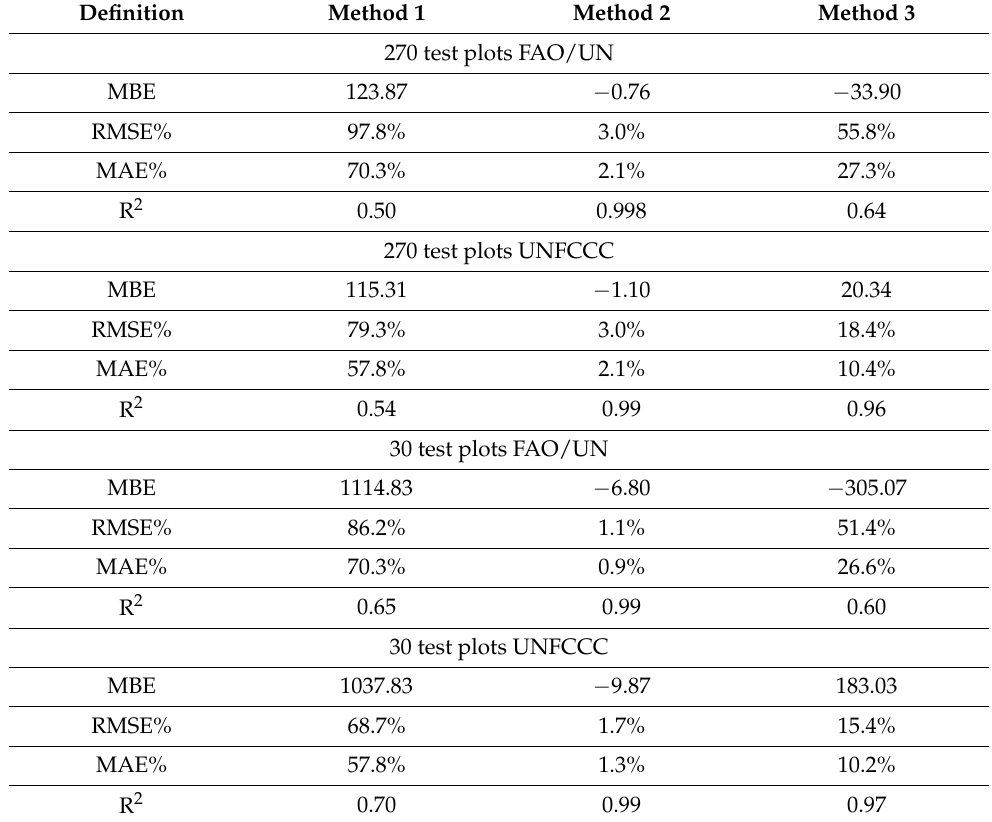
Table 6. Results comparison for the methods according to the FAO/UN and the Kyoto Protocol